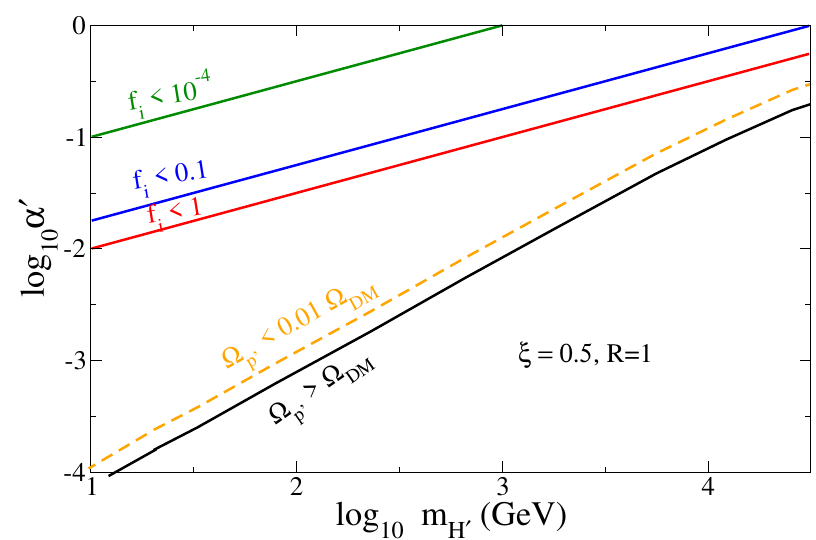
Figure 5: Black curve: contour of correct relic density for a model with only p (cid:48) sym- metric dark matter, reconstructed from Ref. [ 23 ] . Dashed curve shows the suppres- sion of the symmetric component when the DM is assumed to be asymmetric. Colored curves are contours of the ionized fraction f i